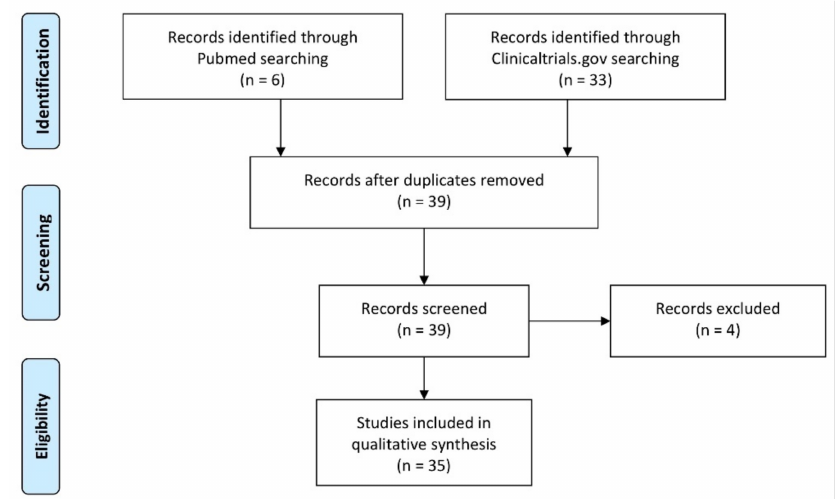
Figure 1. Study flow diagram.